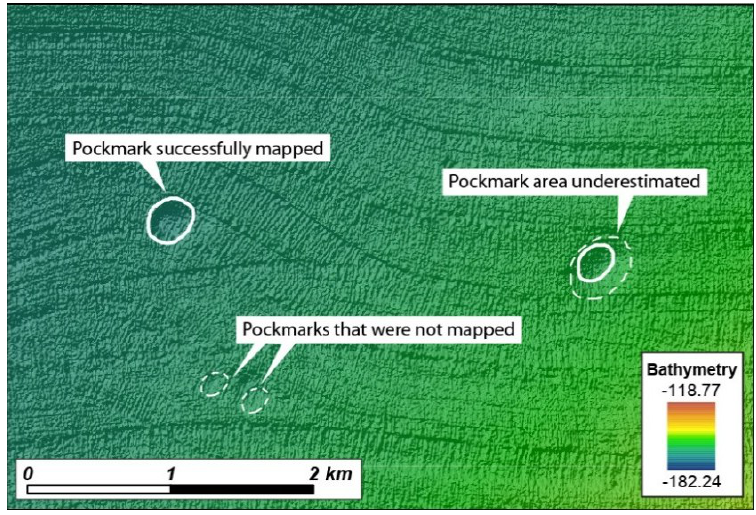
Figure 15. Detail of the original Malin Deep dataset and the mapping results based on the smoothed bathymetry.